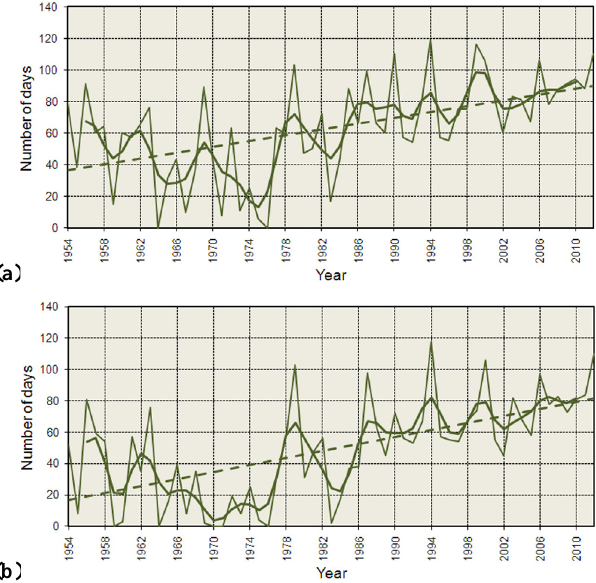
Fig. 3. Dates of onset (green squares) and cessation (red squares) of PMV ≥ 2 discomfort in Athens at 14:00 for (a) calm and (b) light wind conditions. No discomfort period occurred for the years 1964 and 1976 for calm and 1959, 1964, 1970, 1971, and 1976 for light wind conditions.